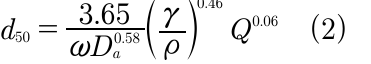
the melt in, and it was connected to a graphite nozzle, available in diameters 1.5, 2.0 and 2.5 mm. Experimental average melt flow rates for these nozzle sizes are given in table 1. Graphite rotating discs with diameters 30, 40, 50, and 60 mm were used throughout the experiments. The hot air blower was used for preheating the atomiser disc before commencing atomisation. A high speed motor was controlled by a voltage regulator with rotation speed detected by an inductive proximity sensor that gave a pulse for each rotation. The speeds used in the experiment were in the range 10,000-30,000